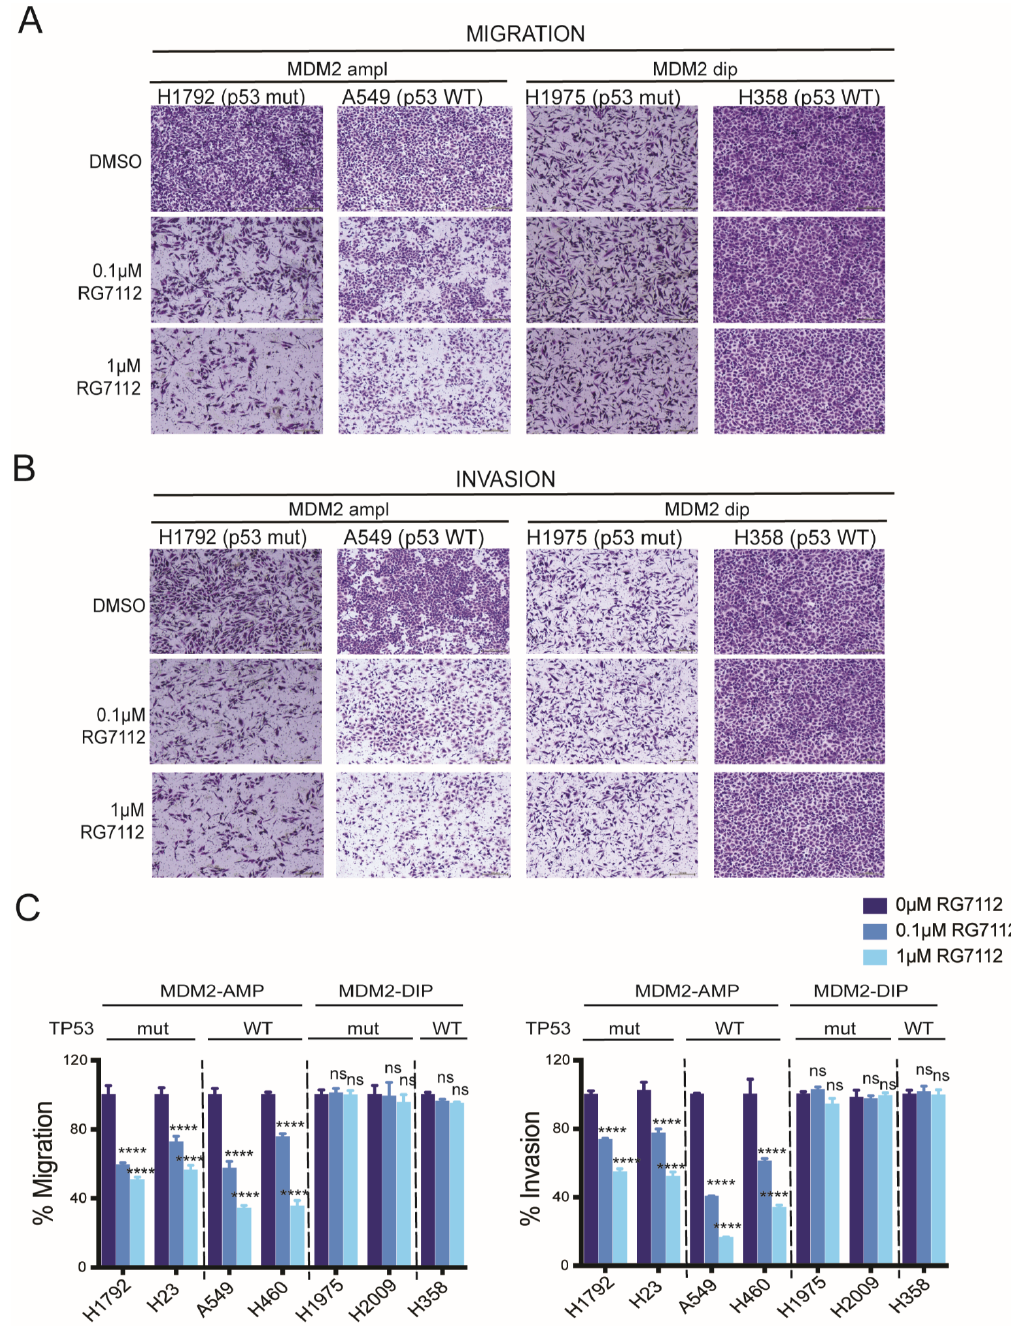
Figure 3. Anti-migratory and anti-invasive effect of MDM2 inhibitor shows MDM2-dependent drug response. ( A ) Representative images of transwell migration assay for H1792 (MDM2 ampl; p53 mutant), A549 (MDM2 ampl; p53 WT), H1975 (MDM2 dip; p53 mutant) and H358 (MDM2 dip; p53 WT group) on treatment with DMSO, 0.1 µ M RG7112 or 1 µ M RG7112 for 48 h. ( B ) Representative images of transwell invasion assay for H1792 (MDM2 ampl; p53 mutant), A549 (MDM2 ampl; p53 WT), H1975 (MDM2 dip; p53 mutant) and H358 (MDM2 dip; p53 WT group) on treatment with DMSO, 0.1 µ M RG7112 or 1 µ M RG7112 for 48 h. ( C ) Quantitation of % Migra- tion (left) and % Invasion (right) for panel of 7 cell lines on treatment with DMSO, 0.1 µ M RG7112 or 1 µ M RG7112 for 48 h. MDM2 ampl and p53 mutation annotations are labelled on the top. One-way ANOVA, p -values for each comparison in results. **** p < 0.0001 and ns non significant. The magnification of the figure is 4 ×